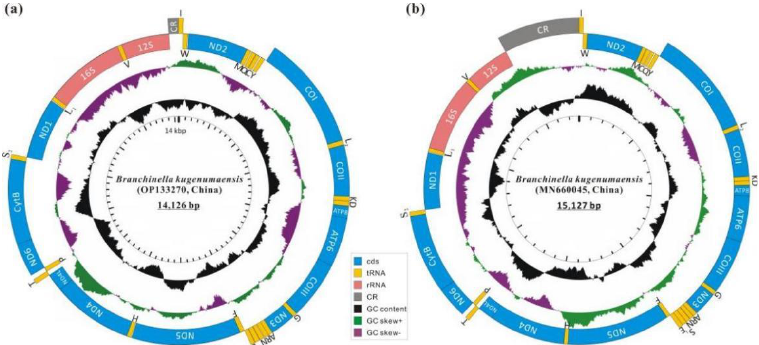
Figure 1. Structural representations of the mitochondrial genomes of B. kugenumaensis from Suqian ( a ) and Jinhua ( b ). Circular maps were drawn with CGView [40] and then modified manually. Genes shown at the outer circle are encoded by the J strand (Foward), and the genes shown at the inner circle are encoded by the N strand (Reverse). The blue, orange, pink, and grey blocks indicate PCGs, tRNAs, rRNAs, and control region, respectively. The tRNAs abbreviations: L1 = trnL (CUN); L2 = trnL (UUR); S1 = trnS (AGN); S2 = trnS (UCN).